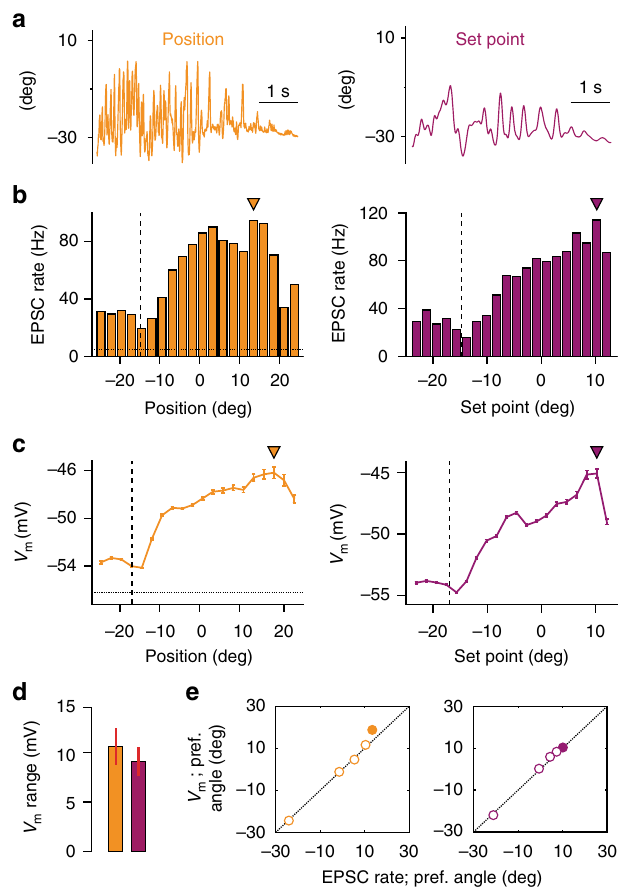
Fig. 3 Kinematic tuning of granule cell synaptic input and membrane potential. a Snapshot of fl uctuating whisker position ( orange , left ) during movement and corresponding change in whisker set point ( purple , right ). b . Histogram of EPSC rate with respect to whisker position ( left ) and set point ( right ) for a single GC. Filled triangles : preferred angles. Dashed horizontal line indicates average quiescent EPSC rate. Vertical line indicates whisker resting position. c Average V m with respect to whisker position ( left ) and set point ( right ) for the same GC. The overall pro fi le of angular tuning is similar to b . Filled triangles : preferred angles. Dashed horizontal line indicates average quiescent V m . Vertical line indicates whisker resting position. d Dynamic range of V m tuning with respect to whisker angle ( n = 26). Value represents average of difference between V m preferred and least-preferred angle for individual GCs. e Correspondence between preferred angle for EPSC rate (measured in voltage-clamp mode) and V m (measured in current-clamp mode) for all GCs ( n = 5). Filled circle : GC shown in b ,